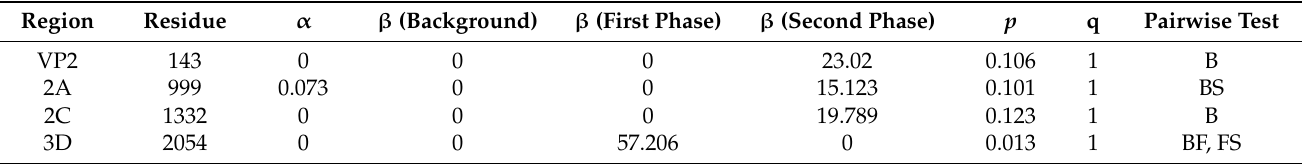
α = site-specific synonymous rate; β = site-specific nonsynonymous rate. The individual pairwise test was set as follows: BF = Background vs. First Phase, BS = Background vs. Second Phase, FS = First Phase vs. Second Phase. Background comprises branches of variants circulating in southern Italy. Permutation p -value was set at ≤ 0.1. Further analyses detected a total of three amino acid residues that were directionally evolving under selection, with two of these sites inferred for SVDV nonstructural regions (Table 3). The residue located at position 2054 (3D region) was also found to be under diversifying selection and evolutionarily characterising the first epidemic phase and sub- ject to strong bias towards alanine ( 𝐵 = 40.77). Table 3. SVDV amino acid residues estimated to be under directional selection in the 2006–2007 SVD epidemic. For each residue the observed residue composition, the root state, and target substitutions are reported. Region